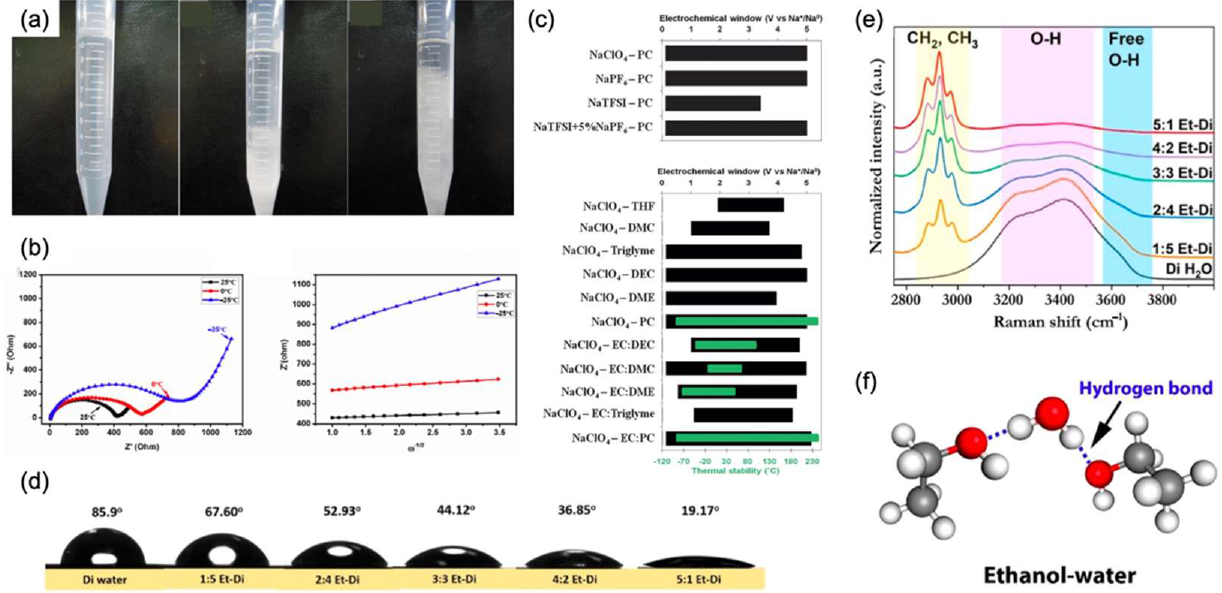
Figure 10. ( a ) On the left is the optical picture of the electrolyte in PBNi-ES at − 25 ◦ C. In the middle is the electrolyte at 0 ◦ C. On the right is the electrolyte at 25 ◦ C. ( b ) In the EIS spectra, the black line represents performance tested at 25 ◦ C, the red line represents 0 ◦ C, and the blue line represents − 25 ◦ C. Reproduced with permission from Ref. [19]. Copyright 2018 Elsevier Ltd. ( c ) The black bar represents electrochemical windows for different electrolytes, while the green bar represents their thermal stabilities. The Y axis represents solvents based on PC with 1 M sodium salts and 1 M NaClO 4 with different other solvents. Reproduced with permission from Ref. [59]. Copyright The Royal Society of Chemistry 2012. ( d ) The picture compares different contact angles of various proportions of ethanol–water. ( e ) Raman scattering spectra of various proportion of ethanol–water. ( f ) The picture represents the new type of hydrogen bond in the ethanol–water system. Reproduced with permission from Ref. [66]. Copyright 2020 American Chemical Society.